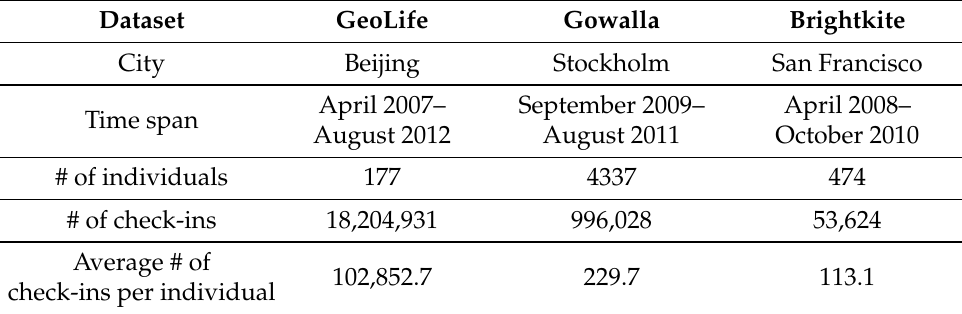
Table 3. Statistical characteristics of datasets after